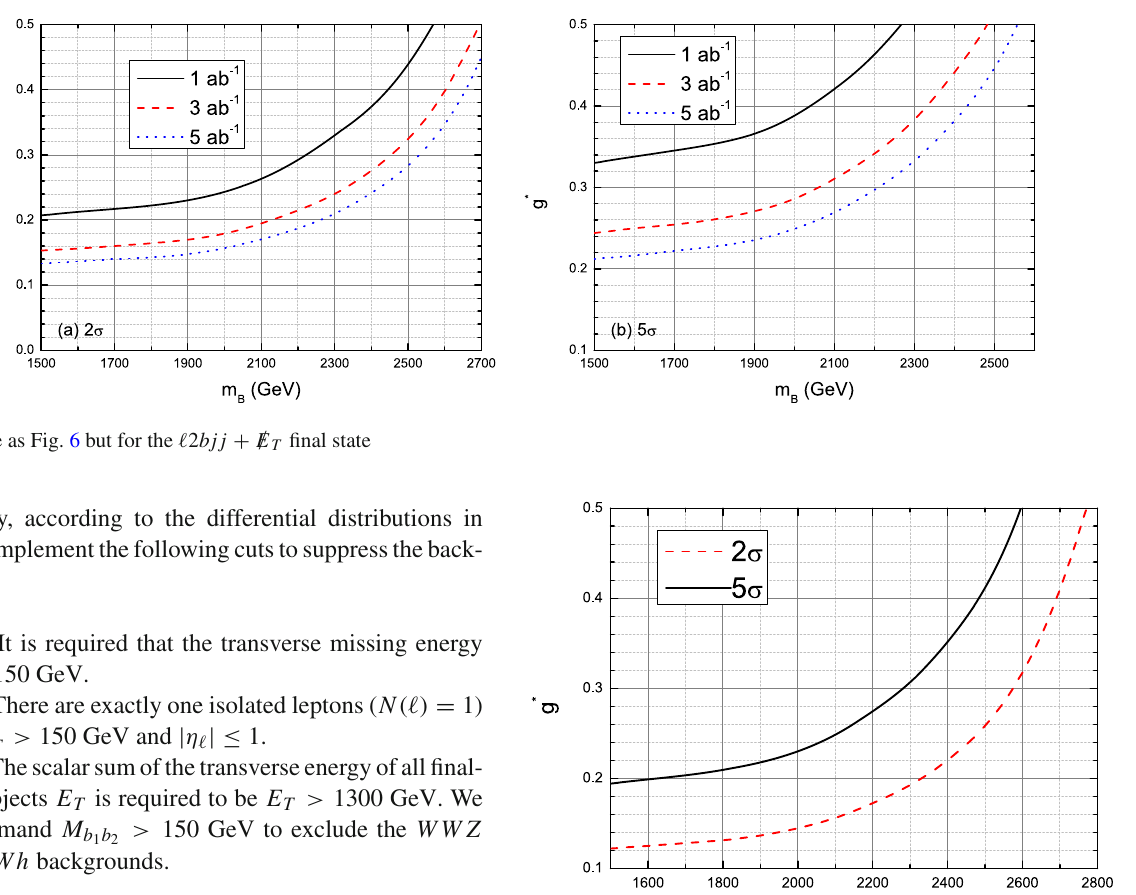
Fig. 6 2 σ exclusion limit (left) and 5 σ discovery prospects (right) contour plots for the 2 (cid:6) 2 b + / E T final state in g ∗ − m B planes at the 3 TeV CLIC with three typical integral luminosity values